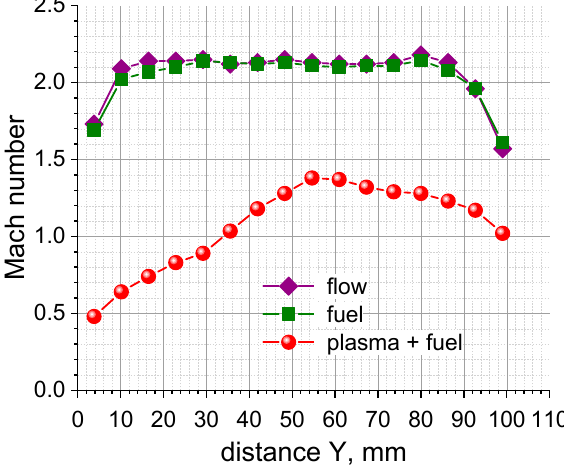
Figure 19. Mach number distribution over the test section of SBR-50 at plasma-assisted combustion: P 0 = 1.8 bar, T 0 = 290 K, ṁ C2H4 = 5.4 g/s, W pl = 13.6 kW.